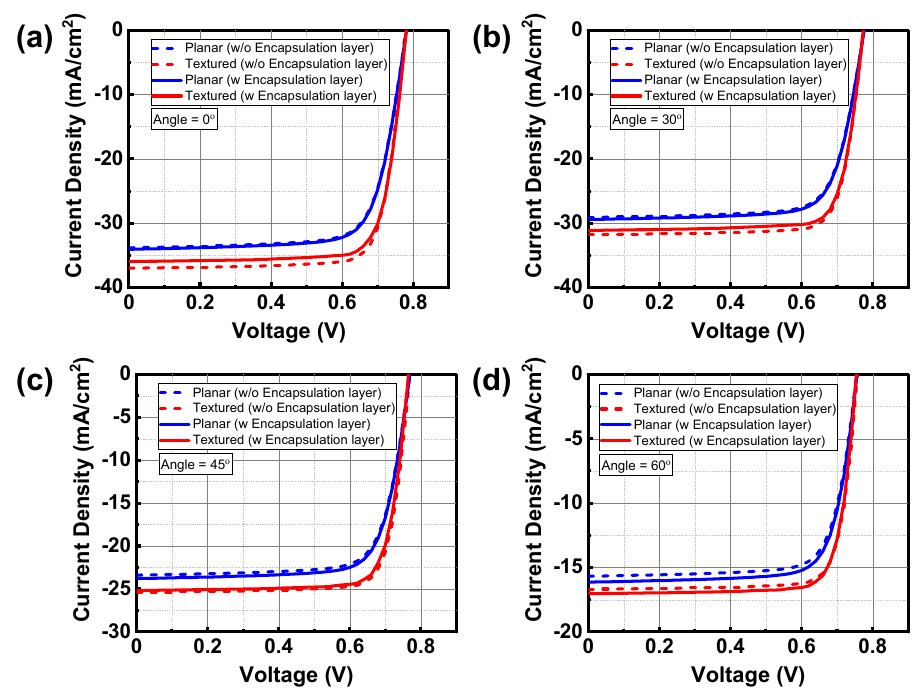
Figure 11. Calculated J–V characteristics of the surface-textured CIGS solar cell without and with the inclusion of the front incoherent layers. For reference, the J–V characteristics of the planar CIGS solar cell are also calculated. The incidence angle of the AM 1.5 sunlight is θ 0 = ( a ) 0 ° , ( b ) 30 ° , ( c ) 45 ° , and ( d ) 60 ° , respectively. Table 1. Calculated short-circuit current density (J SC ) of the planar and surface-textured CIGS solar cells without and with the inclusion of the front encapsulation layers, which are taken from Figure 11. The unit of J SC is mA/cm 2 . The improvement percentage of J SC in the surface-textured CIGS so- lar cell over the planar CIGS solar cell is denoted in the parenthesis whether the front incoherent encapsulation layers are included or not.